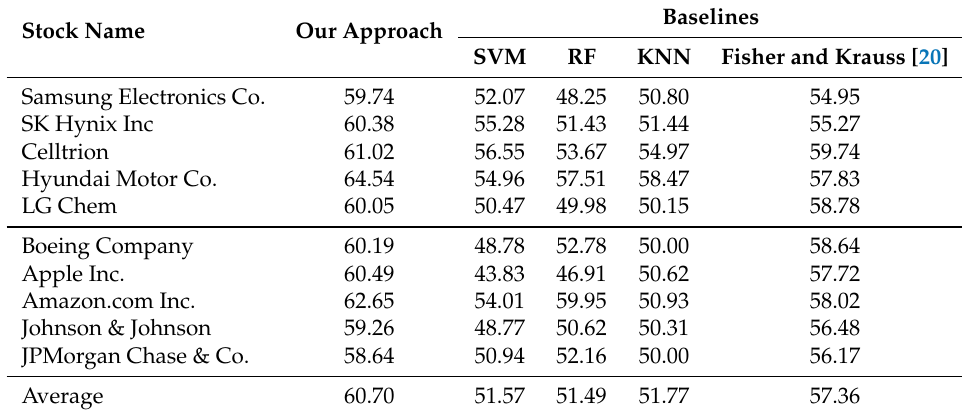
Table 6. Comparisonof our proposed approach and baselines over all study periods. Support